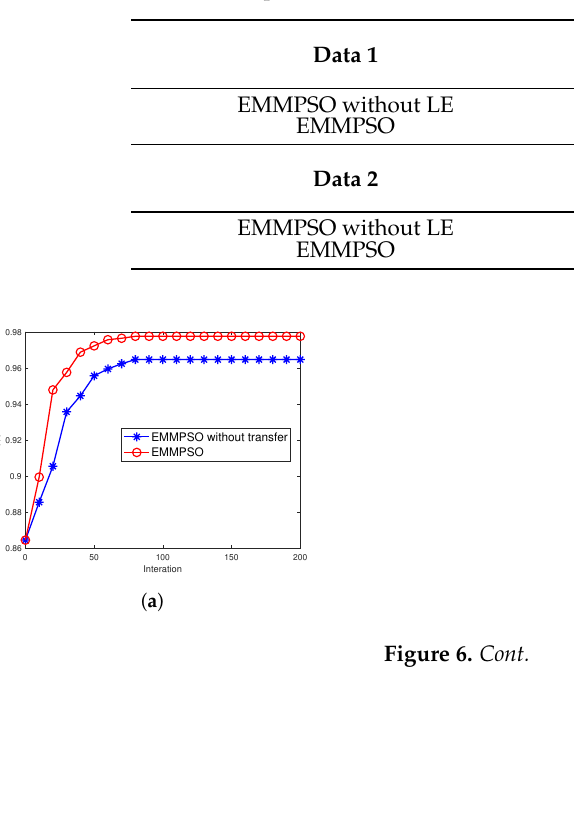
Table 1. Comparison of EMMPSO and EMMPSO without Local Exploration on data 1 and data 2.